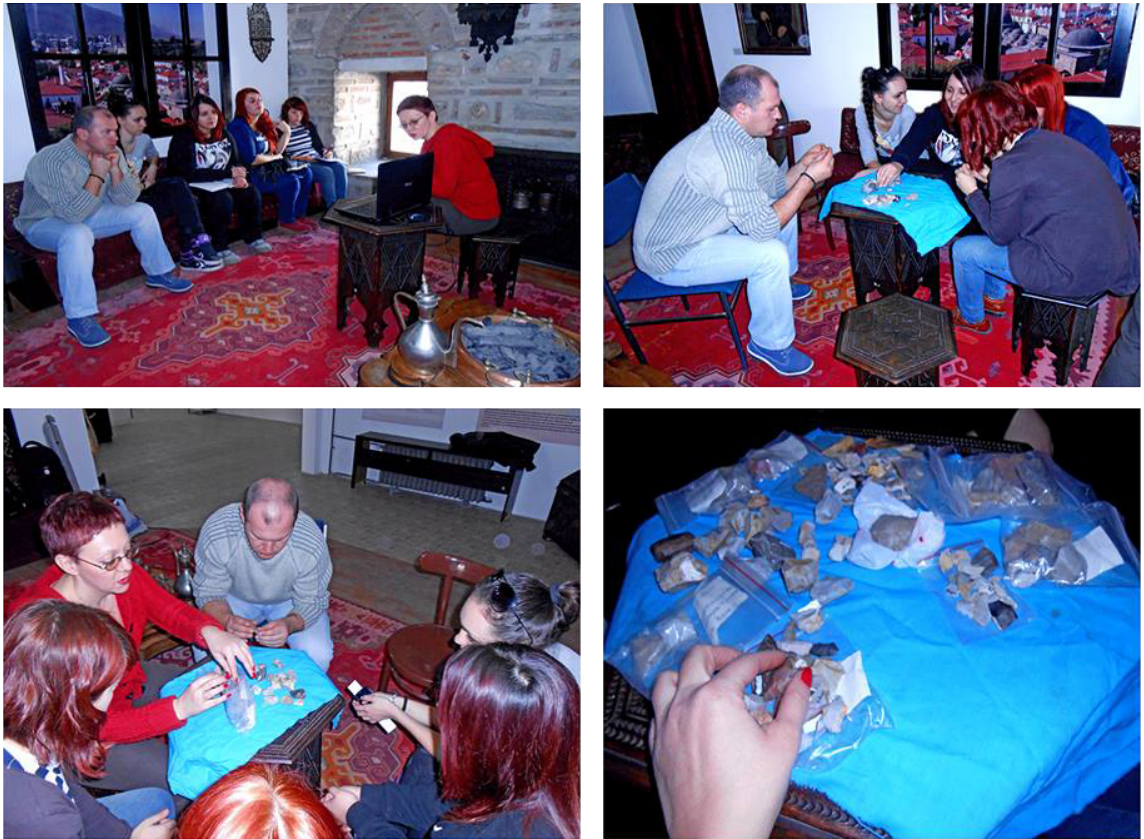
Figure 1. Stone tools workshop I, Museum of the Old Bazaar, Skopje, 18 February 2014. (Photos by Vasilka